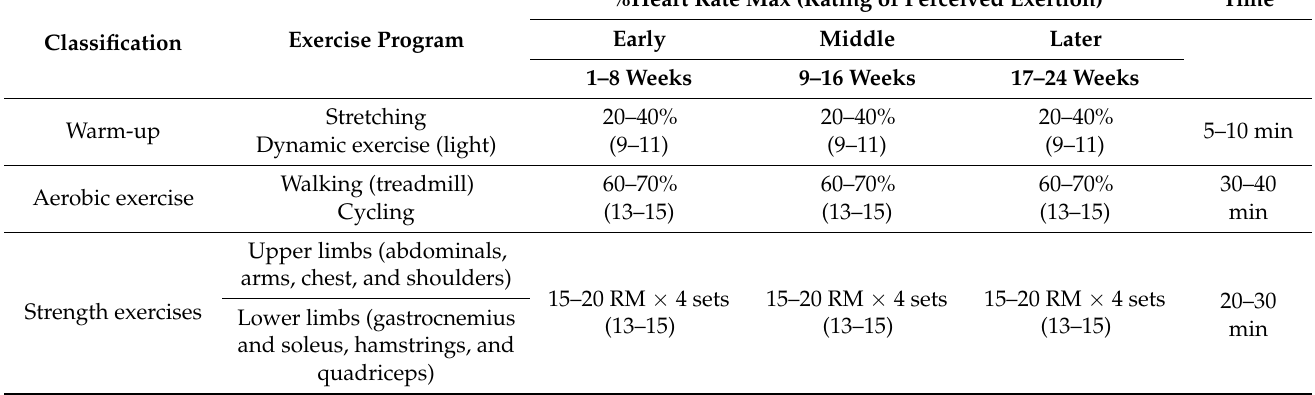
Table 1. Exercise